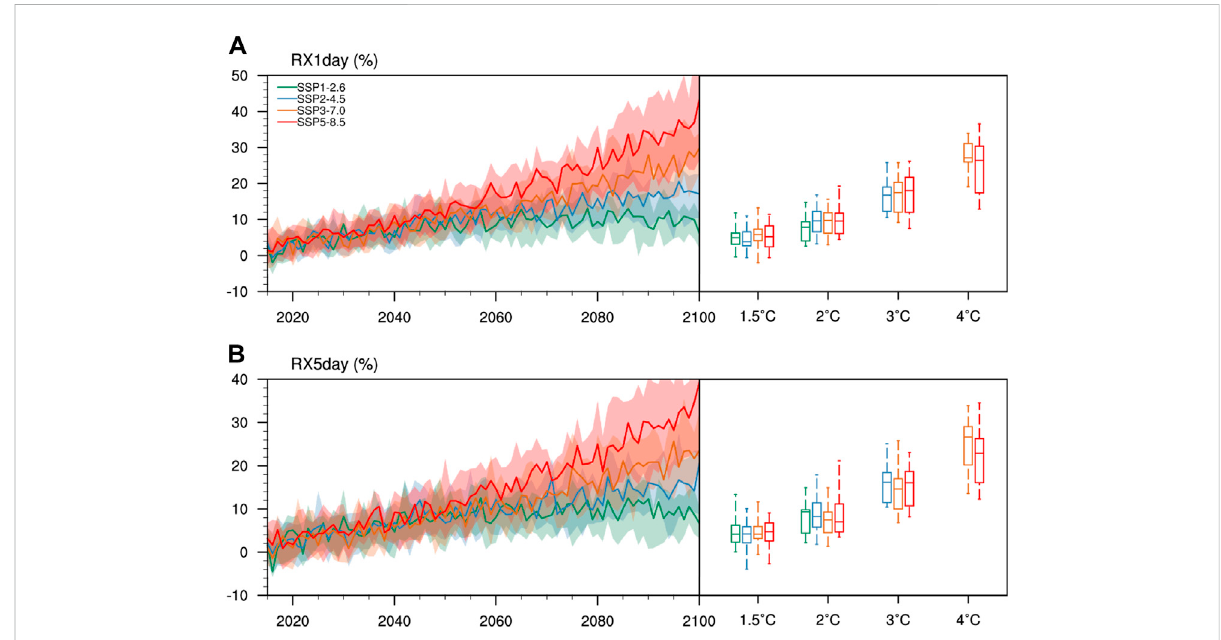
FIGURE 2 Future changes in the areal-weighted mean (A) RX1day and (B) RX5day under different emission scenarios relative to the reference period of 1995 – 2014. The solid lines in the left panel denote the MMEs and the shadings represent the projection uncertainty ranging from 25th to 75th quantiles. Box-and-whisker plots on the right panels depict the changes in precipitation extremes averaged over China under the 1.5, 2.0, 3.0, and 4.0 ° Cwarmerclimatewithrespecttothepresentday.Herein,thesolidlinesintheboxesdenotetheMMEs,andtheboundsoftheboxesdenote the 25th and 75th percentiles of the model simulations. The whiskers outside the boxes range represent all the inter-model ranges. Units: